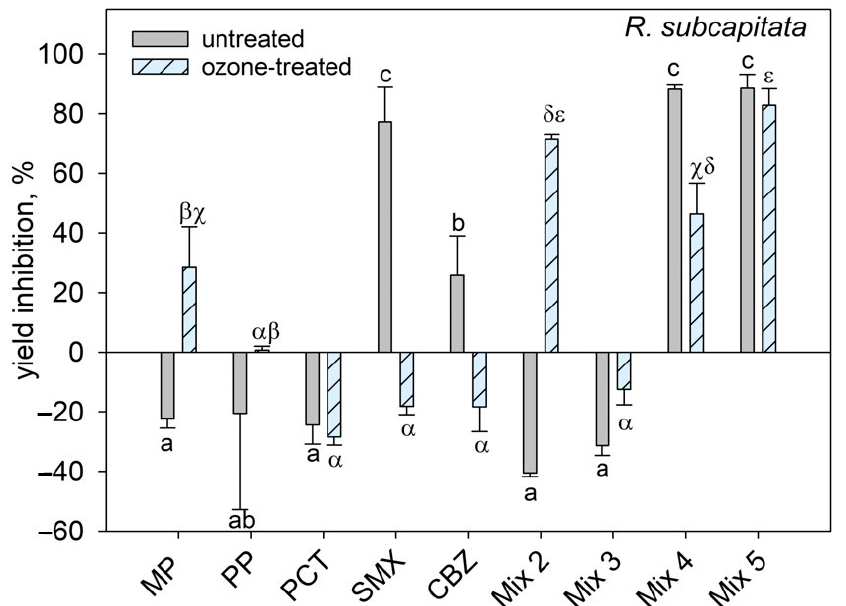
Figure 4. The yield inhibition of Raphidocelis subcapitata after 96 h of exposure to untreated and ozone-treated solutions. The bars represent the mean, and the error bars represent the standard error of the mean. Mix 2: MP+PP; Mix 3: MP+PP+PCT; Mix 4: MP+PP+PCT+SMX; Mix 5: MP+PP+PCT+SMX+CBZ. The different Latin letters indicate significant differences among untreated samples; different Greek letters indicate significant differences among ozone-treated samples.